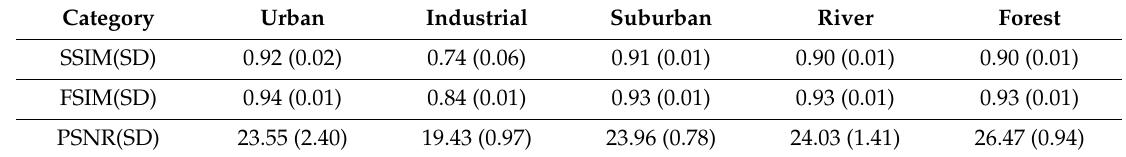
Table 4. Structural similarity index measure (SSIM) and PSNR scores in five